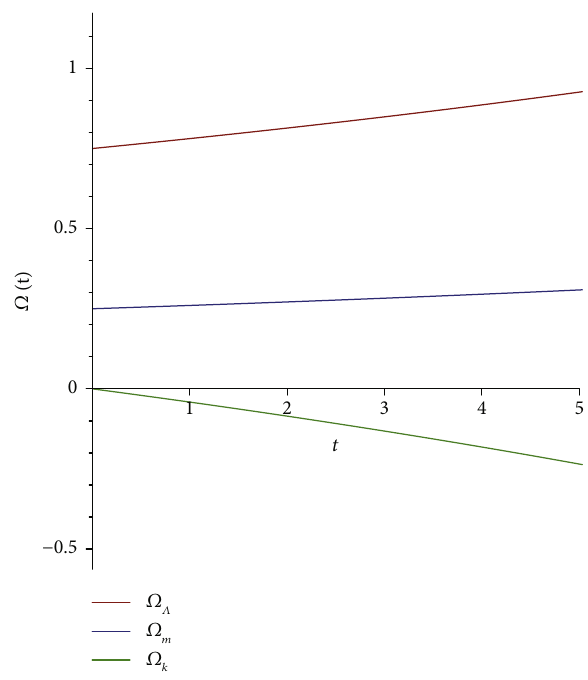
Figure 7: Plot of Ω ð t Þ versus t for k = +1